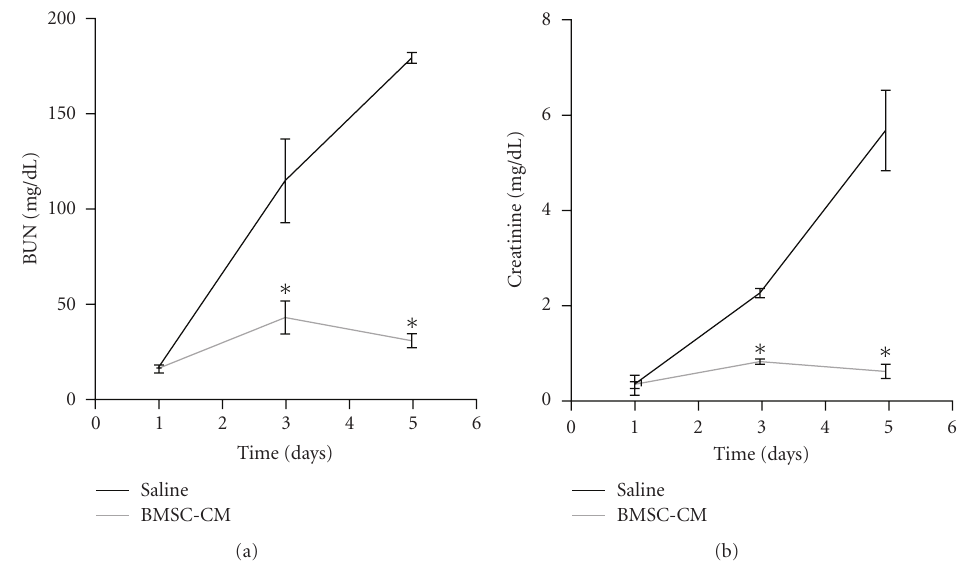
Figure 2: BMSC-CM prevents onset of severe AKI . Blood was collected from rats subjected to lethal cisplatin (7.5mg/kg) i.p. via tail snip 1, 3, and 5 days following cisplatin administration. The rats were treated at 3, 9, 24, 48, and 72 hours following cisplatin administration, with 1mL of either physiological saline ( n = 4), or BMSC-conditioned medium ( n = 3) i.v. (a) BUN and (b) creatinine were measured to monitor the extent of renal injury as a function of time after cisplatin. ∗ P < 0 . 01 by Student’s t -test.